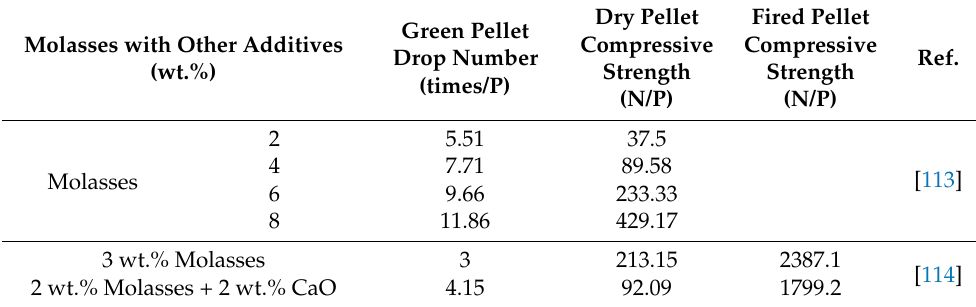
Dry Pellet Fired Pellet Compressive Compressive Ref. Strength Strength (N/P) (N/P)